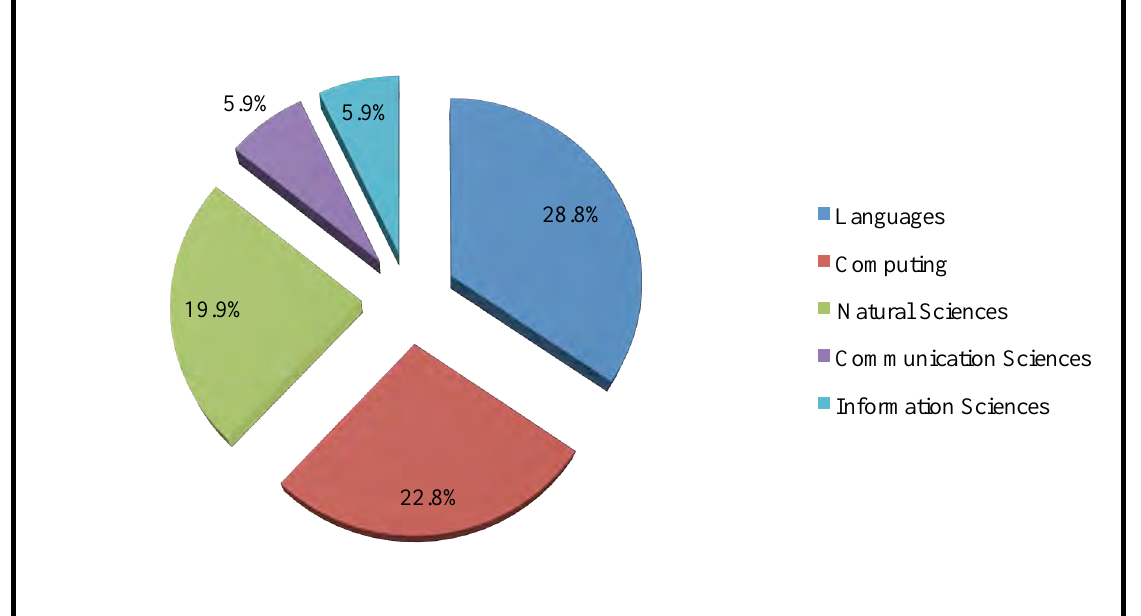
Figure 2: Distribution of respondents in terms of teaching areas